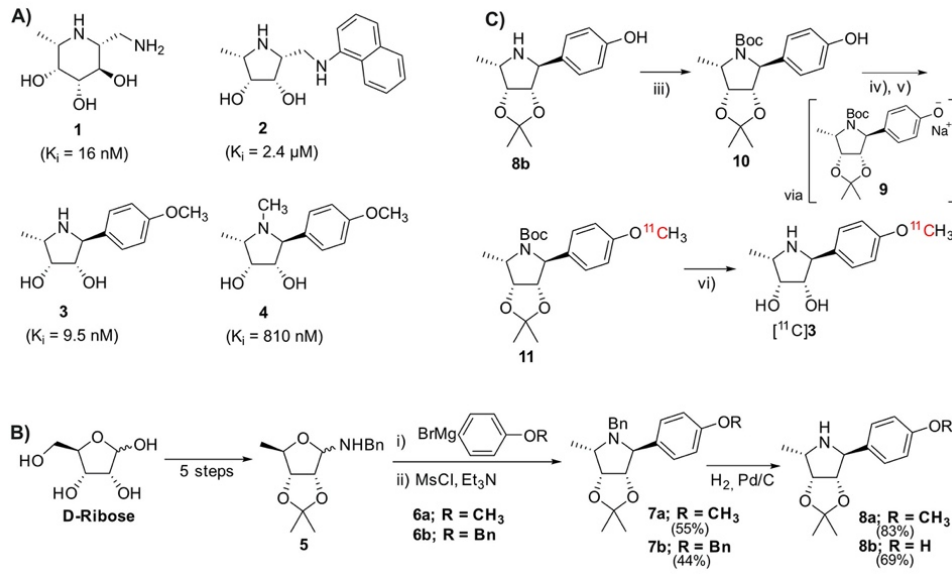
Figure 1. ( A ) Structures and K i values of known inhibitors of α -fucosidase [8–10]; ( B ) Overview of the synthetic route to core pyrrolidine structure from D-ribose [10]; ( C ) Synthetic route toward precursor 10 and subsequent radiosynthesis of [ 11 C] 3 via the phenoxide 9 and radiolabeled intermediate [ 11 C] 11 . Reagents and conditions: (iii) Boc 2 O, Et 3 N, DCM, RT. (iv) NaH, CH 3 CN, ultrasonification, 5 min, RT. (v) [ 11 C]CH 3 I, CH 3 CN, 110 ◦ C, 5 min. (vi) 6M HCl, 140 ◦ C, 5